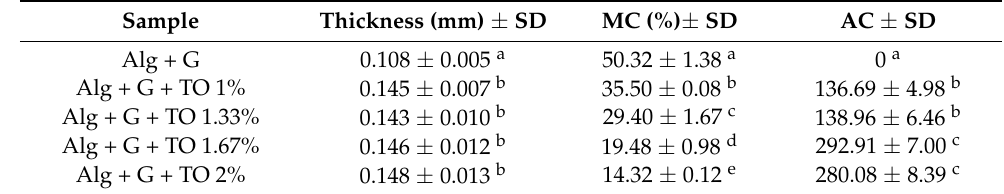
Table 4. Thickness (mm), moisture content (MC, %), and antioxidant activity (AC, µ mol Trolox/100 g) of the studied samples; SD means standard